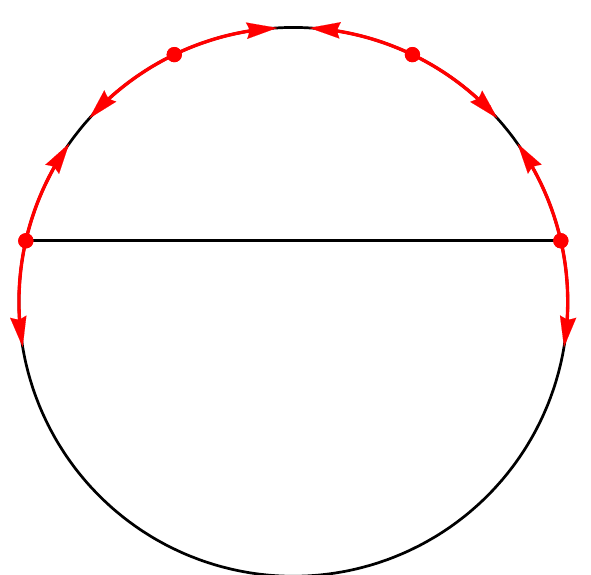
Figure 6 . Schematic depiction of the expected mechanism of covering the moduli space of 0-branes in the k = 7 model. The dots represent the solutions found in this paper using the traditional approach, while the red arrows show how the solutions can be moved by marginal deformations. The actual length of the arrows is unknown and they may or may not